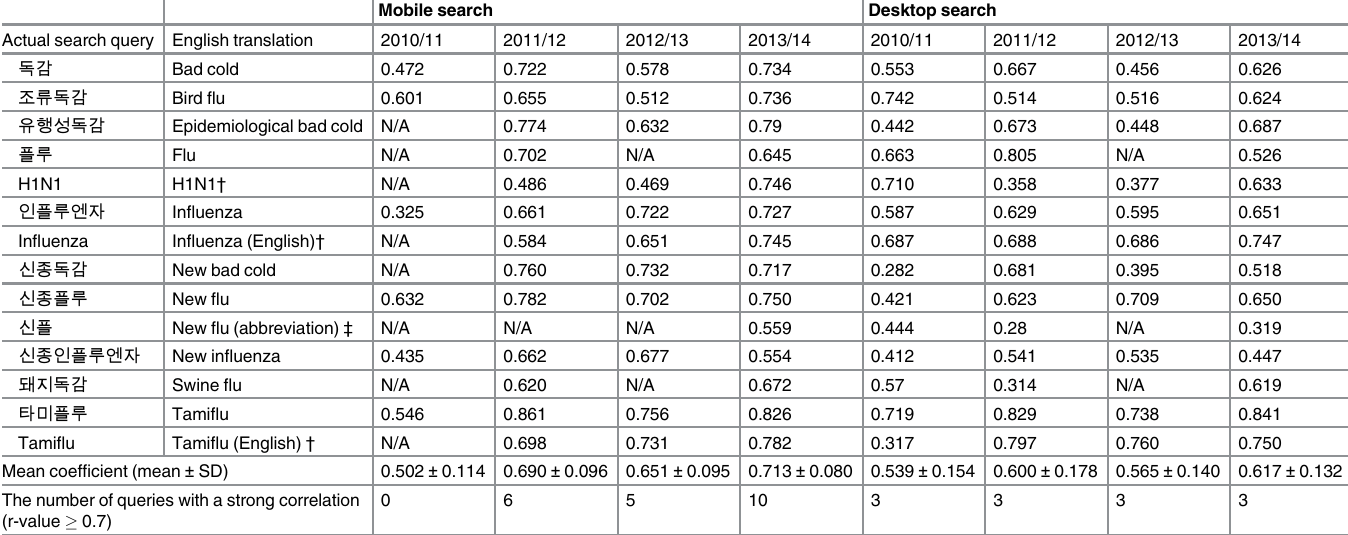
Table 2. Correlation coefficients a between KCDC virologic data and mobile and desktop device search query data from epidemiological years 2010/11 through to 2013/14. Mobile